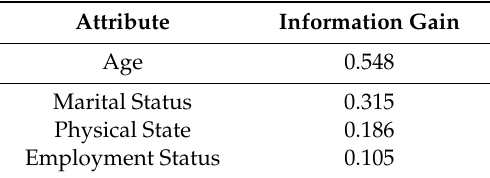
Table 4. Information gain of each attribute.